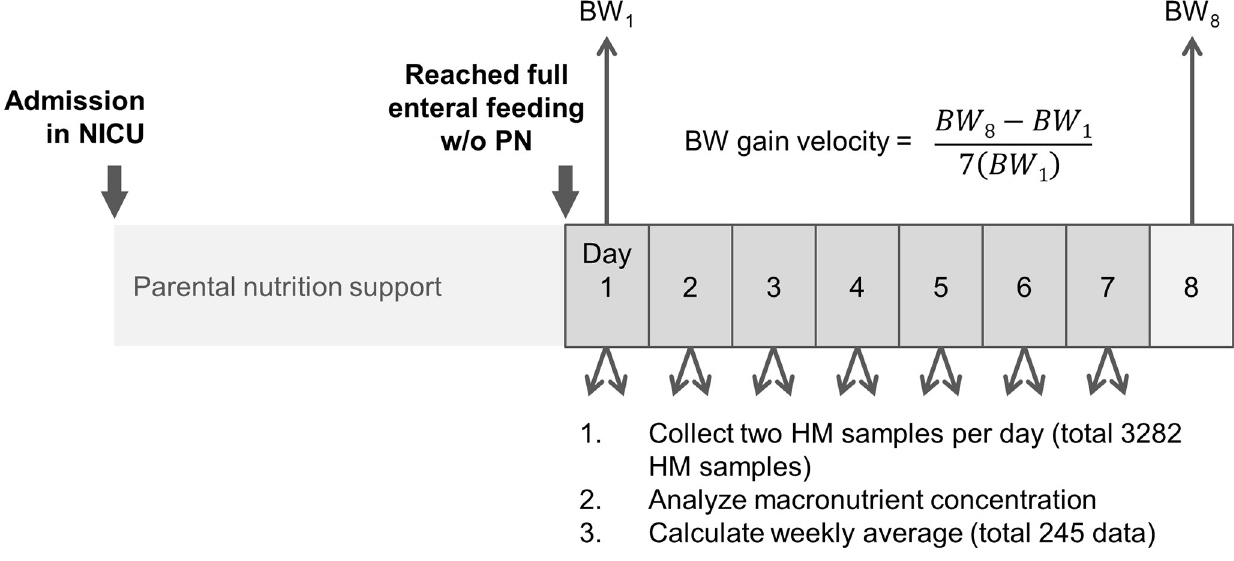
Fig 2. Time relationship between milk analysis and growth